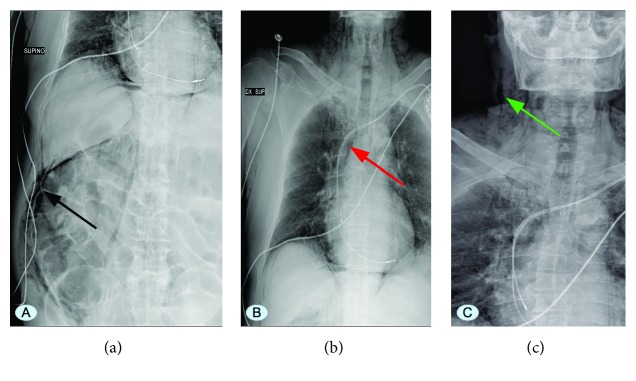
(a) Abdominal X-ray showing subcutaneous emphysema, pneumomediastinum, pneumoretroperitoneum, and right subdiaphragmatic free air (black arrow). (b) Chest X-ray showing pneumomediastinum (red arrow). (c) Neck X-ray showing right cervical subcutaneous emphysema (green arrow).